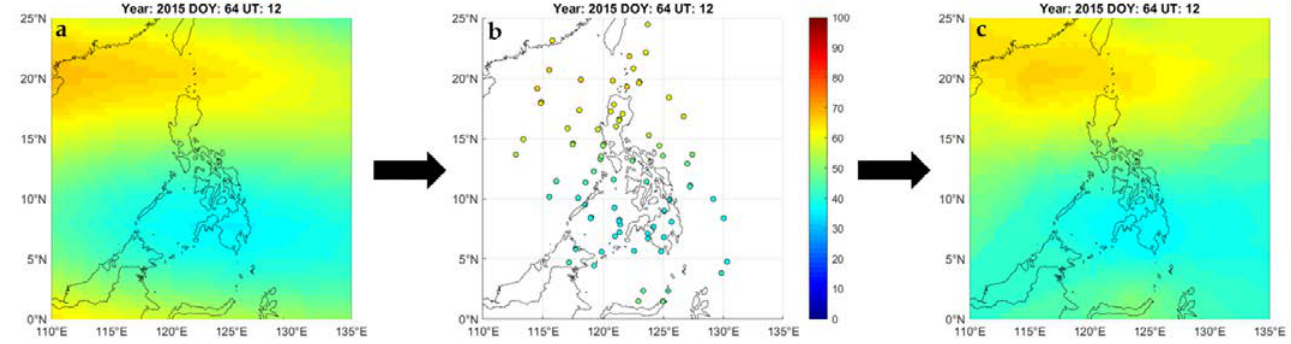
Figure 4. ( a ) A GIM map is taken from the IONEX file. ( b ) VTEC values from different points of the GIM map were taken. The points were chosen from the varying number of chosen GNSS stations based on Figure 3. ( c ) The map is recreated using kriging based on ( b ).